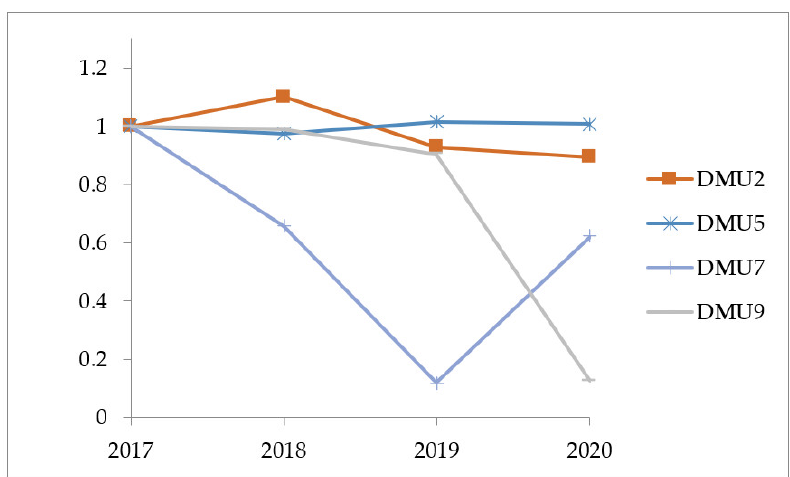
Figure 8. Cumulative Malmquist index (CMI) .